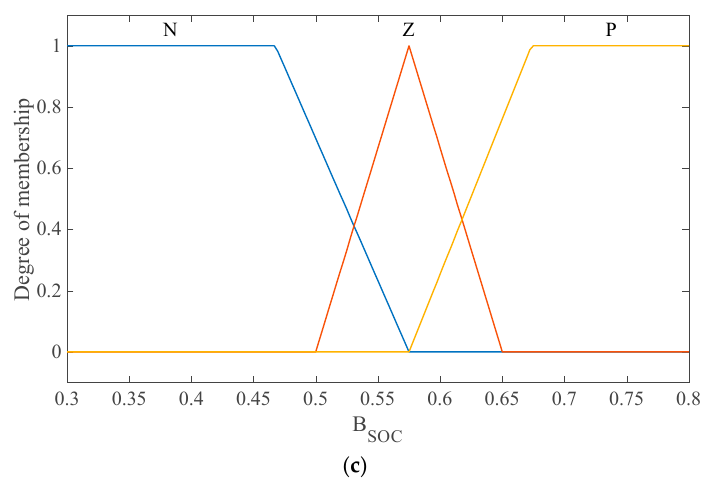
Figure 6. Membership function of the inputs. ( a ) Function of the ship’s power load demand; ( b ) Function of the power of solar energy; ( c ) Function of the SOC of the battery.